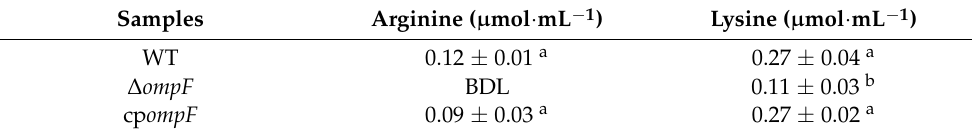
Figure 6. Adhesion to or invasion of epithelial cells by different C. sakazakii isolates. The asterisks indicate that the percent invasion by the mutant was significantly different ( p < 0.01) from that by the wild_type strain. Table 1. The concentration of arginine and lysine in cell